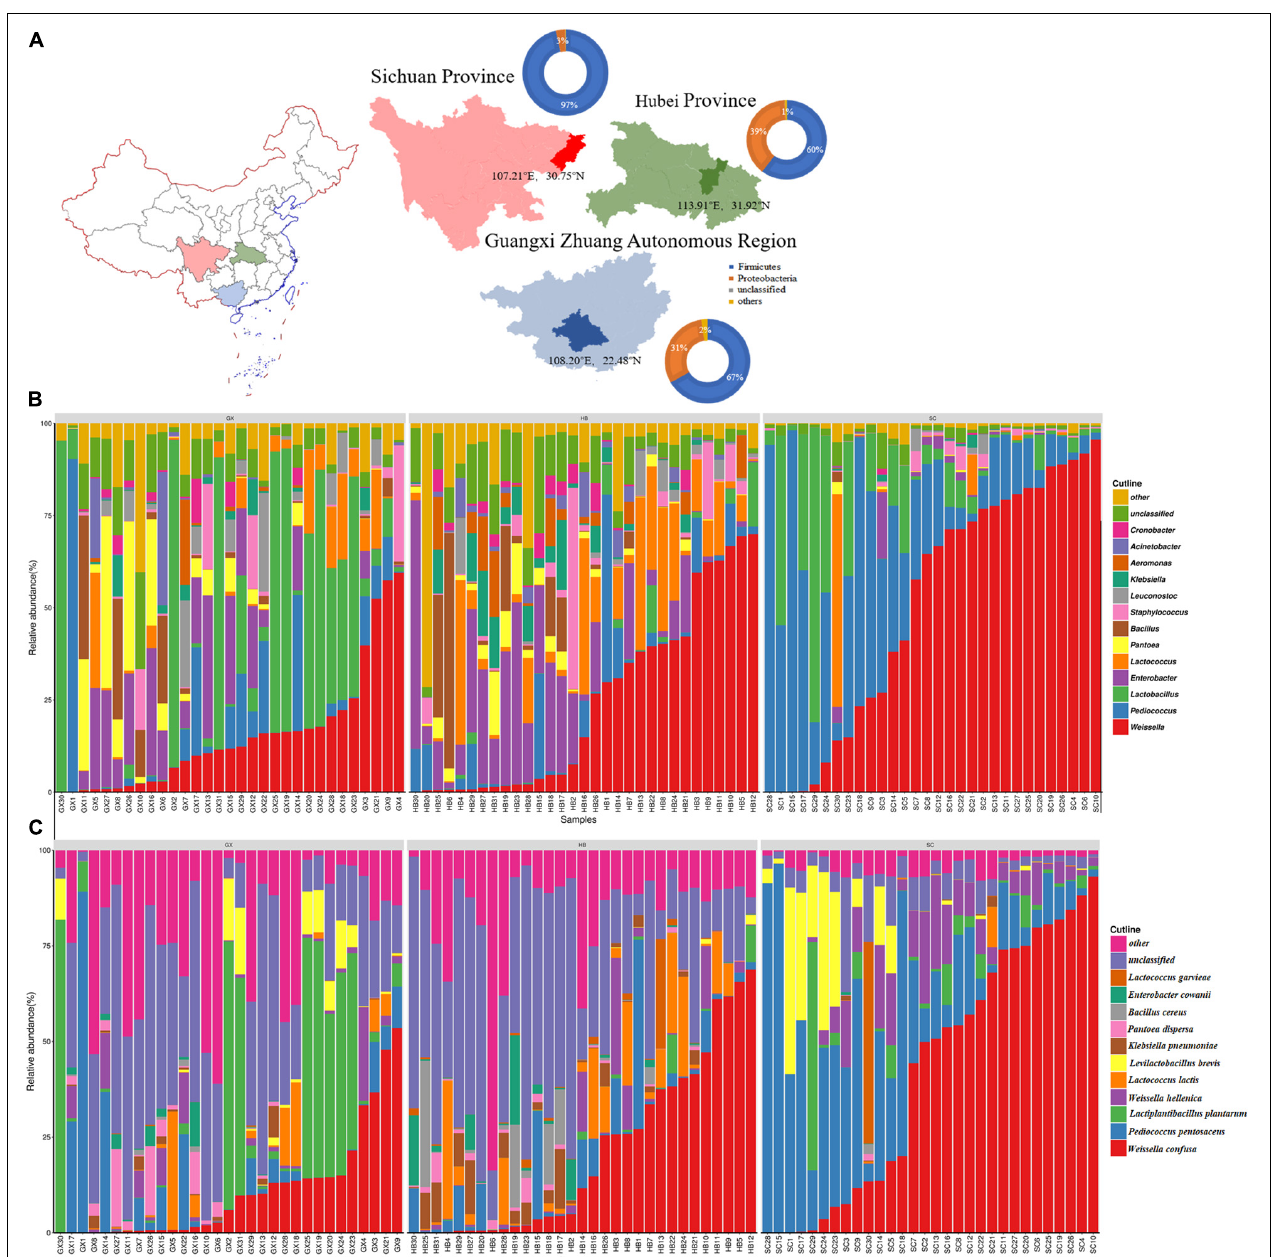
FIGURE 2 | Analysis of location, α -diversity, and dominant phyla in the samples of rice wine koji from different regions. Phyla, genera, and genus with a mean relative abundance of > 1.0% were defined as “dominant” and those remaining as “others.” (A) Location of sampling sites. The pie chart represents the relative abundance of the dominant bacterial phyla. (B) Histogram of relative abundance of dominant bacterial genera in samples from different regions. (C) Relative abundance and bacterial diversity of rice wine koji at the species